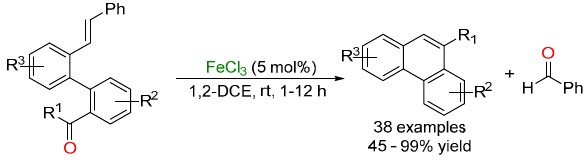
Scheme 15. General equation for the synthesis of